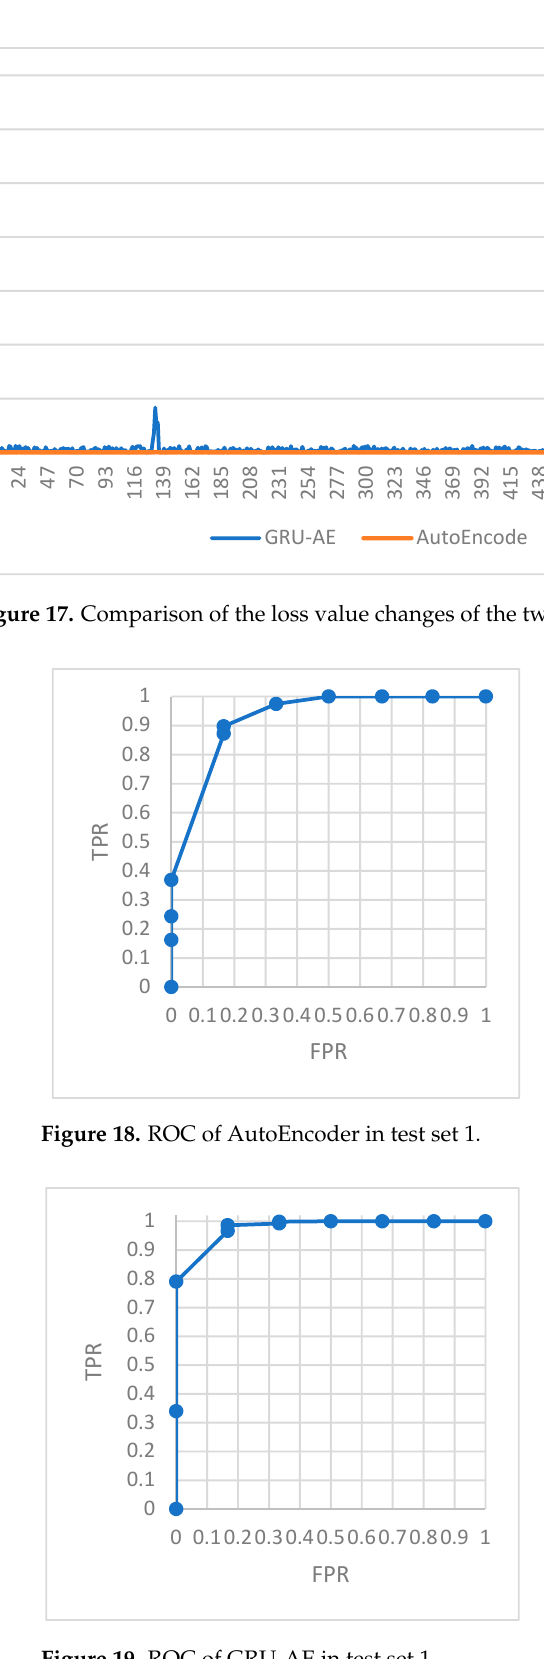
Figure 20. ROC of AutoEncoder in test set 2.